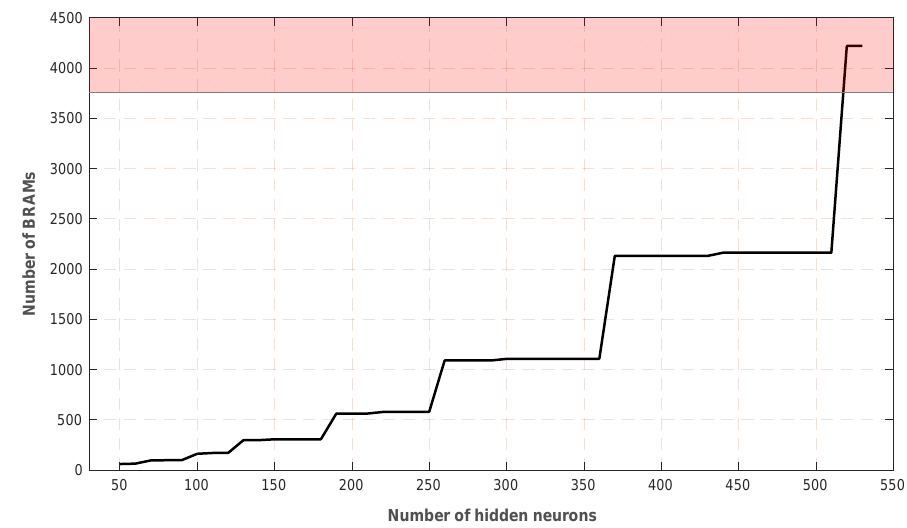
Figure 5. Memory usage as a function of the number of hidden neurons, ˜ N . The memory usage is expressed in number of required 18 Kb BRAM blocks. The colored area indicates the threshold that makes this implementation non-implementable on current FPGAs, due to insufficient memory